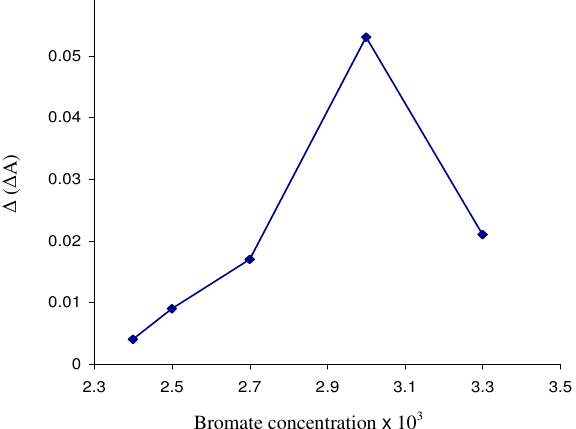
Figure 5. Influence of BrO 3− concentration on the analytical signal. Conditions: H safranin, 3.4 × 10 −5 M formaldehyde 0.4 µ g/mL; temperature, 28 °C and time of 1.0 min from initiation of the